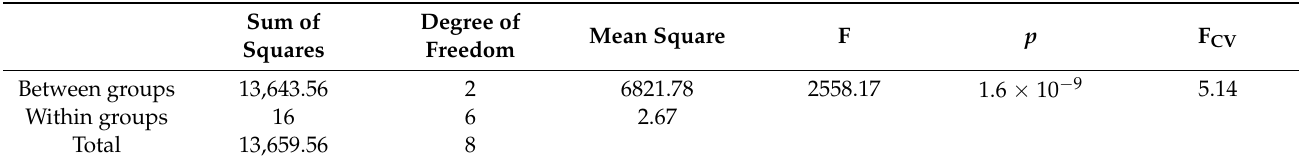
Table 2. Results of ANOVA for the size of alginate